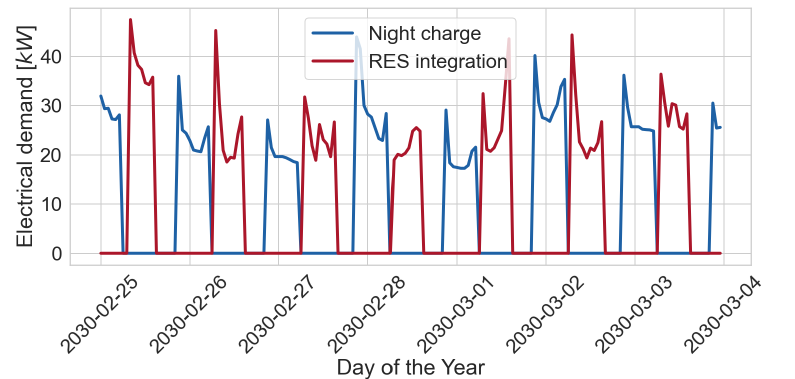
Figure 6. A week-example of the electric vehicle charging profiles considering the “RES integration” and “Night charge” strategies implemented in RAMP